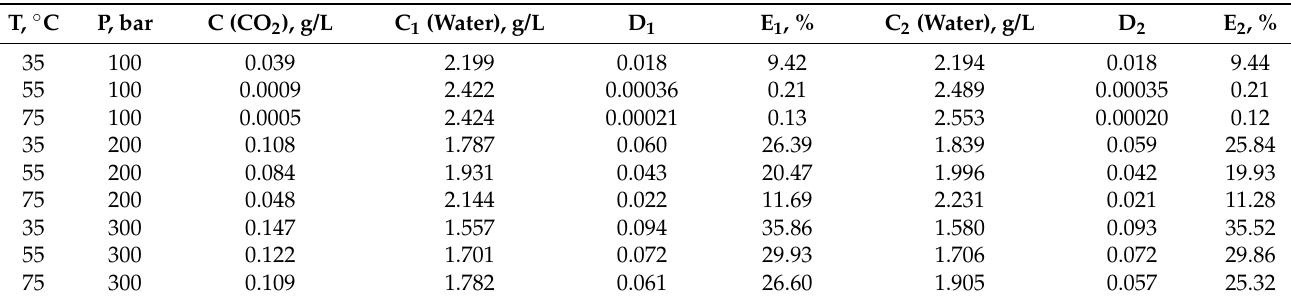
Table A2. Concentrations, distribution coefficients and extraction ratios of caffeine distribution in CO 2 –water–PEG-1500 system, initial concentration of caffeine in water–PEG solution is 2.427 g/L. Lower index 1 defines data obtained via at-line SFC analysis of CO 2 -rich phase and subsequent calculation using mass balance, lower index 2—data obtained via direct offline UV-spectroscopy analysis of a sample of water-polymer phase after